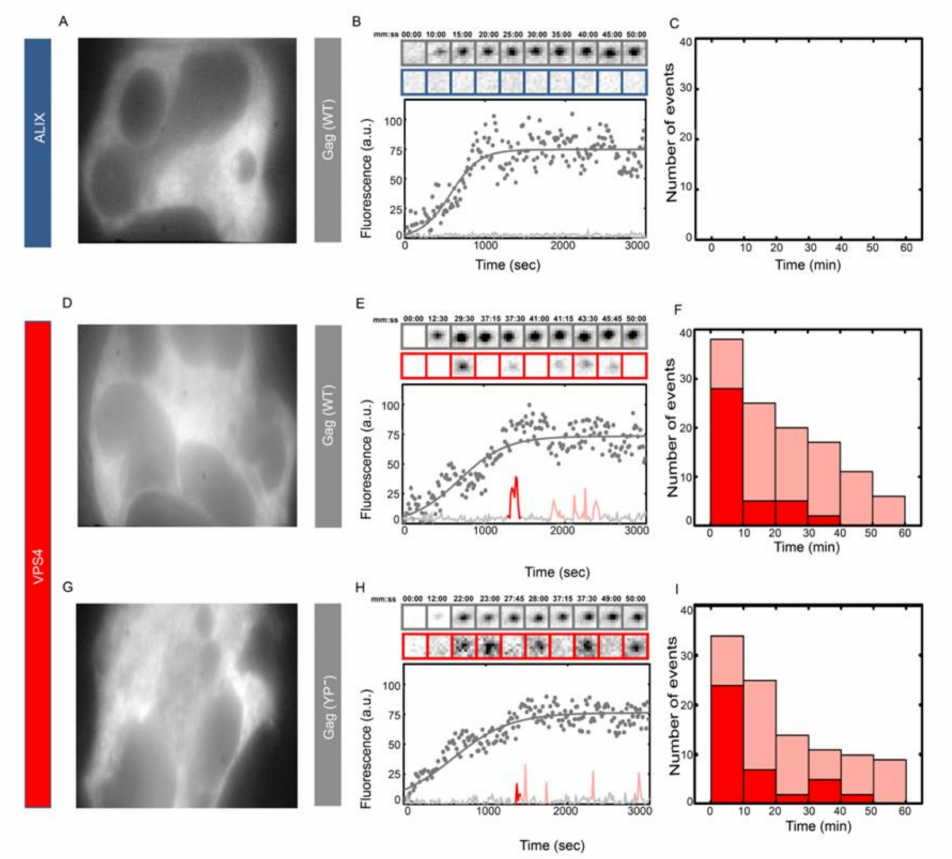
Figure 4. Multiple transient recruitments of VPS4 into HIV Gag WT and Gag (YP-) VLPs under ALIX depletion. HeLa cells were treated with two rounds of siRNA against ALIX. ( A – C ) HeLa ALIX–h37–eGFP cell line treated with siRNA against ALIX and then transfected with 1500 ng of Gag–mCherry WT. An individual multinucleated cell was chosen ( A ) and a representative HIV Gag–mCherry VLP assembly in this cell is shown in ( B ) with intensity plots (as gray dots and fitted with gray line) and cropped TIRF images of the Gag (top, gray) and ALIX (bottom, Blue). In 40 VLPs